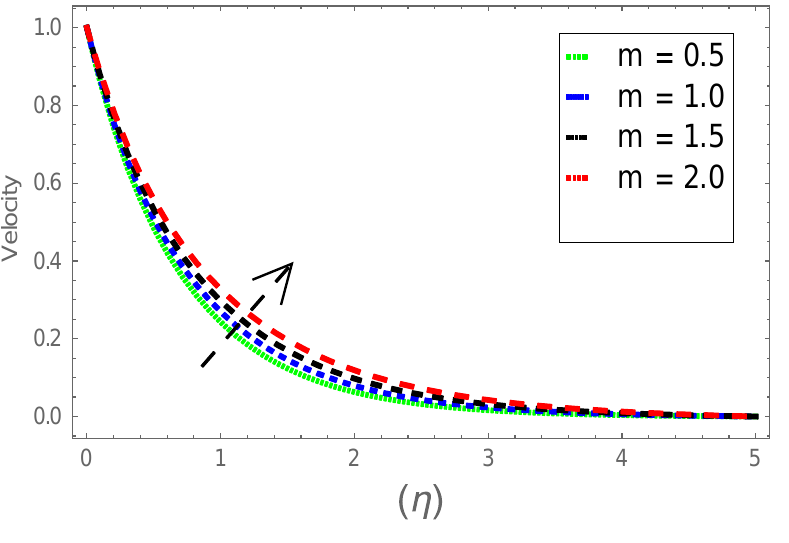
 Figure 6. Consequence of ( m ) via f (cid:48) ( η )